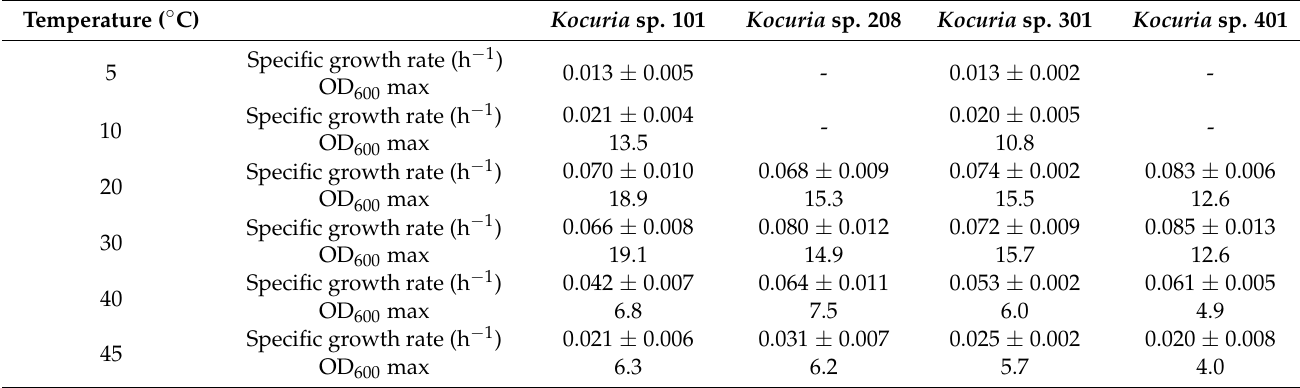
Table 1. Effect of different temperatures on specific growth rate and maximum OD 600 of isolated Kocuria sp.